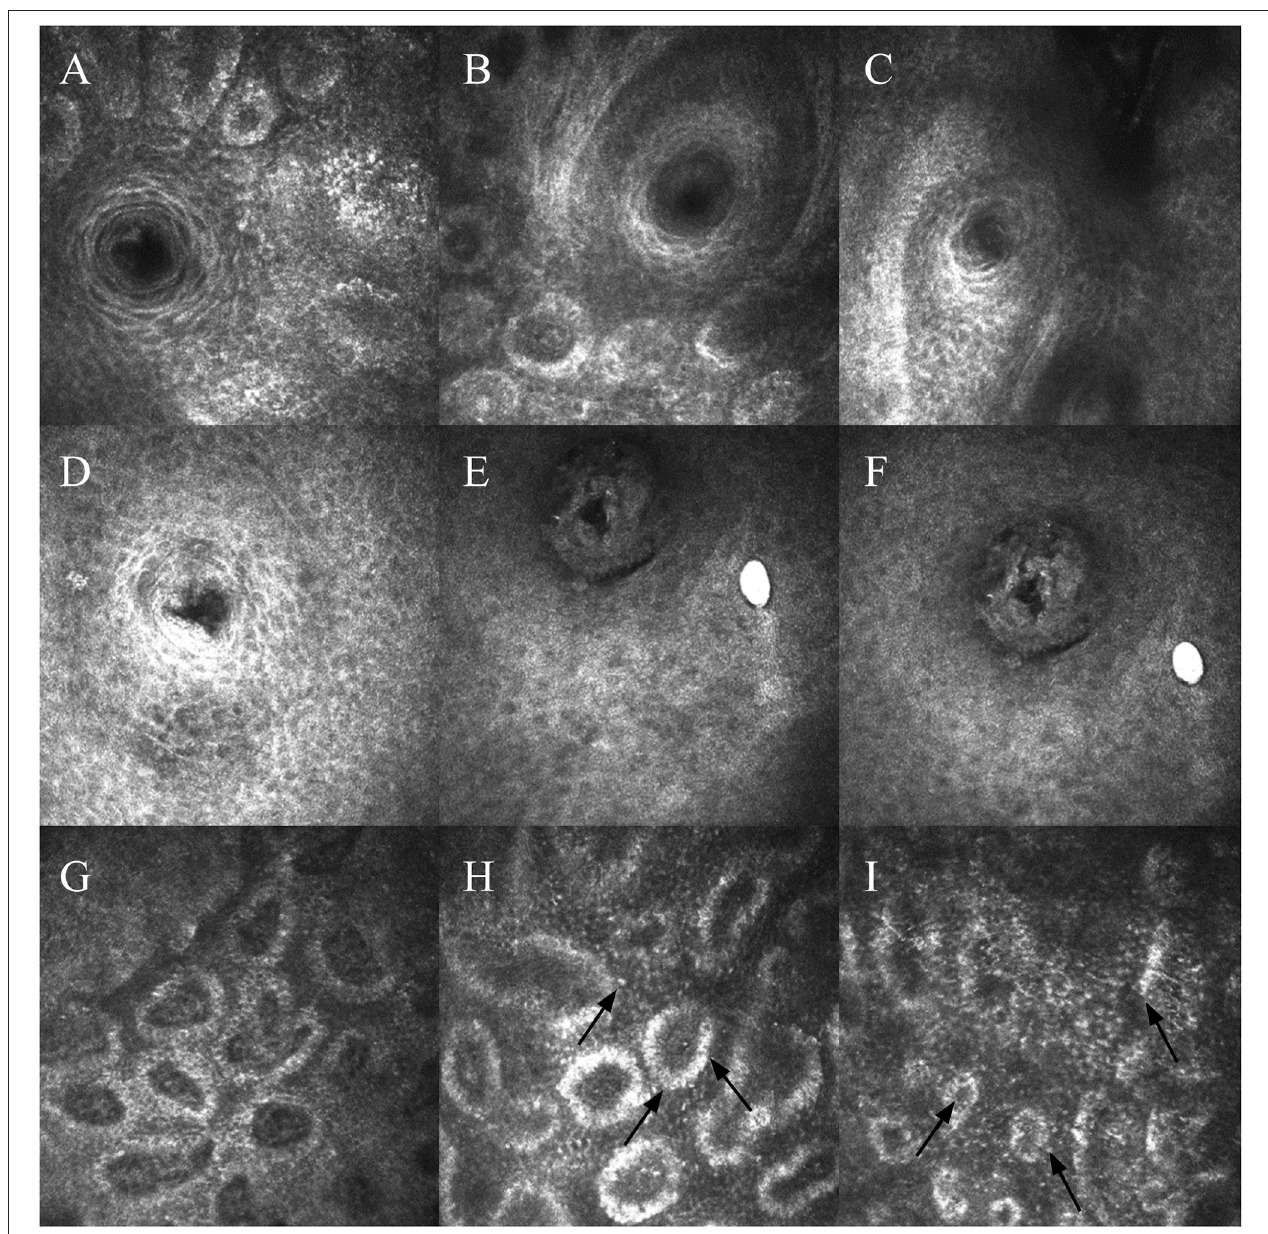
FIGURE 2 | (A–C) Meibomian gland openings of patients with liquid meibum. Cells surrounding the opening are arranged neatly, with regular borders. (D–F) Meibomian gland openings of patients with solid meibum. Morphology has changed, and the glands become blocked. The morphology of cells surrounding the opening has changed, and the arrangement is looser. (G) Image of a patient with liquid meibum. The glands have a certain degree of dilatation. (H,I) Images of patients with solid meibum. There is more dilatation and fusion between the acini. Black arrows indicate inflammatory cells.